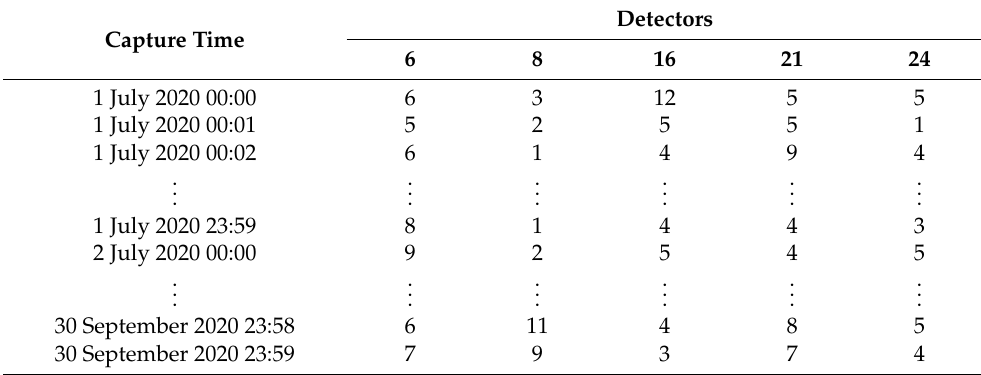
Table 1. Examples of pedestrian flow data. Capture